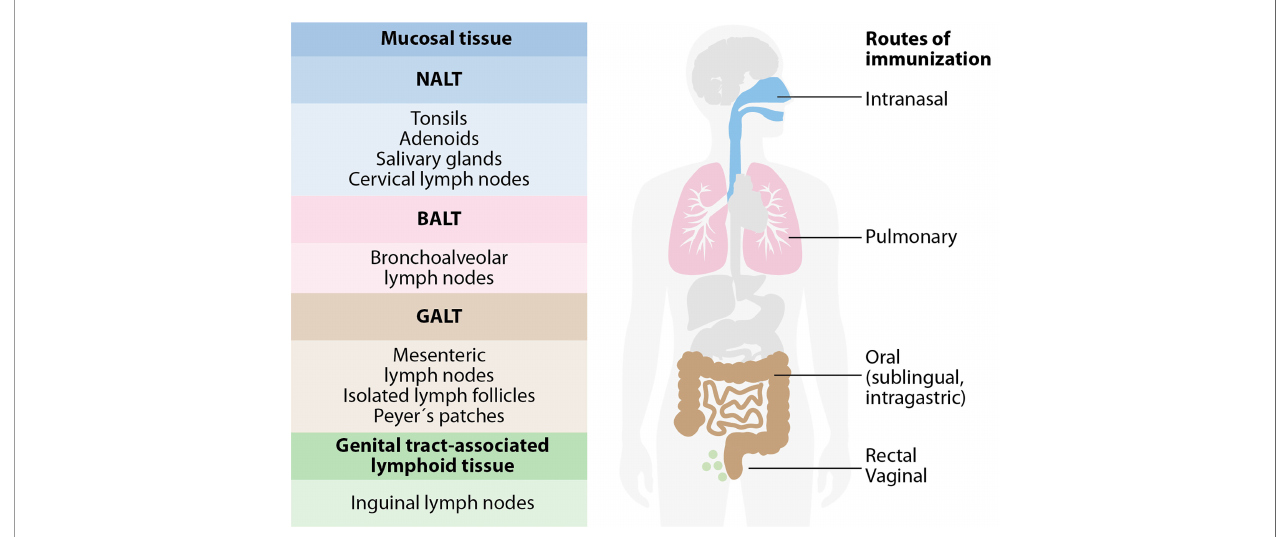
FIGURE 2 | The mucosa-associated lymphoid tissue (MALT). MALT has subcompartments: nasopharynx-associated lymphoid tissue (NALT), bronchus-associated lymphoid tissue (BALT), gut-associated lymphoid tissue (GALT), and genital-associated lymphoid tissue (GENALT). The compartmentalization of mucosal immune responses constrains the selection of vaccine administration routes. Intranasal vaccination is preferred for targeting the respiratory system, while oral and sublingual vaccinations are effective for gut immunity. Rectal immunization allows immunity in the colon, rectum, and the urinary tract to a certain extent. Intravaginal vaccination is the most effective for antibody and T cell immunity in the urinary